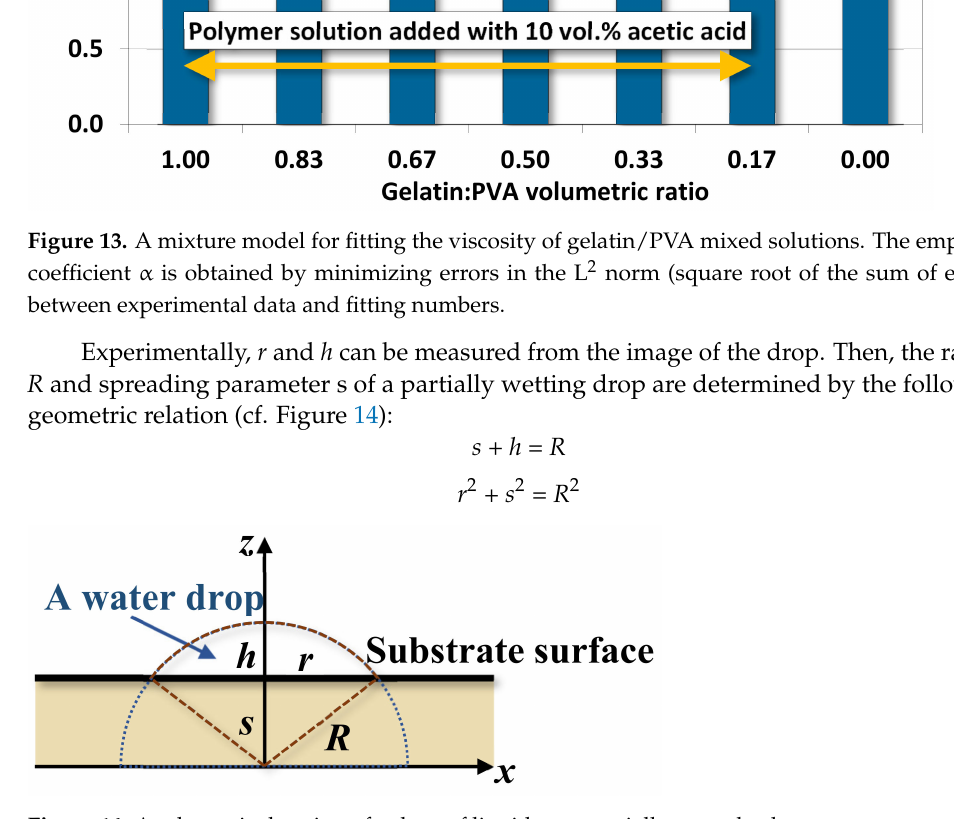
Figure 14. A schematic drawing of a drop of liquid on a partially wetted